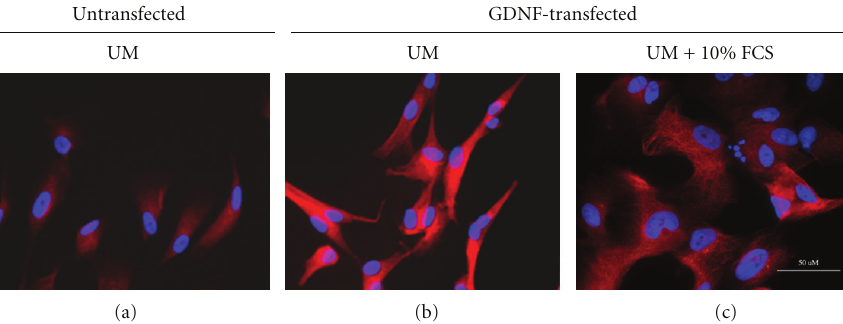
Figure 5: GDNF expression profiles in nontransfected and transfected cNPCp19. GDNF expression profiles were evaluated by immunocytochemistry (ICC) on cNPCs using an anti-human rabbit poly clone antibody. (a) Nontransfected cNPCs in UM; (b) pCAG- PyF101-GDNF plasmid transfected cNPCs in UM; (c) pCAG-PyF101-GDNF plasmid transfected cNPCs in UM containing 10% FBS for 5 days.